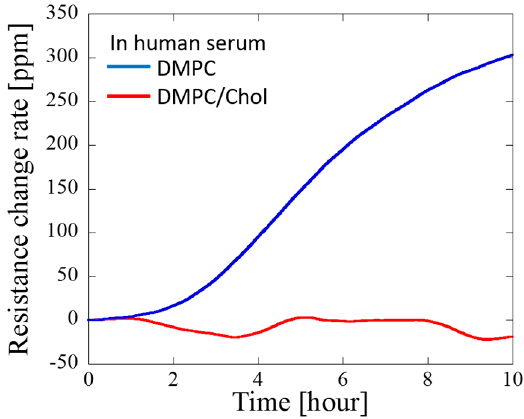
Figure 3. Resistance change rate of the cantilever immobilized with DMPC liposomes and DMPC/Cholesterol liposomes in human serum.